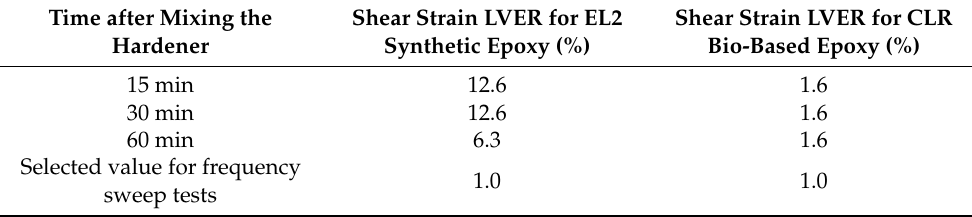
Selected value for frequency sweep tests